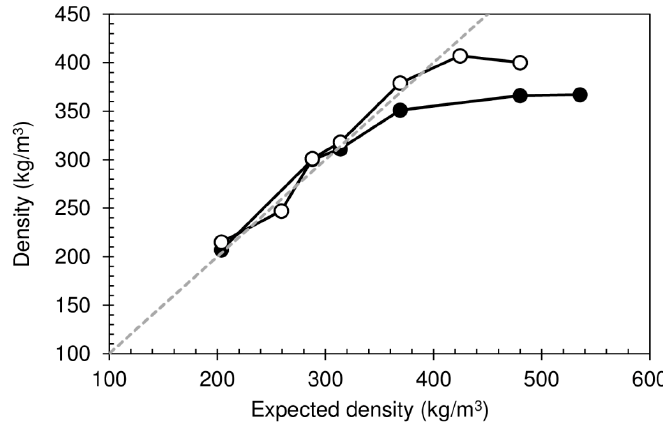
Figure 5. Density of dry particleboards bonded with sour cassava starch foam. White circles: without HPT; black circles: with HPT. Dashed line shows coincidence between measured and expected densities.